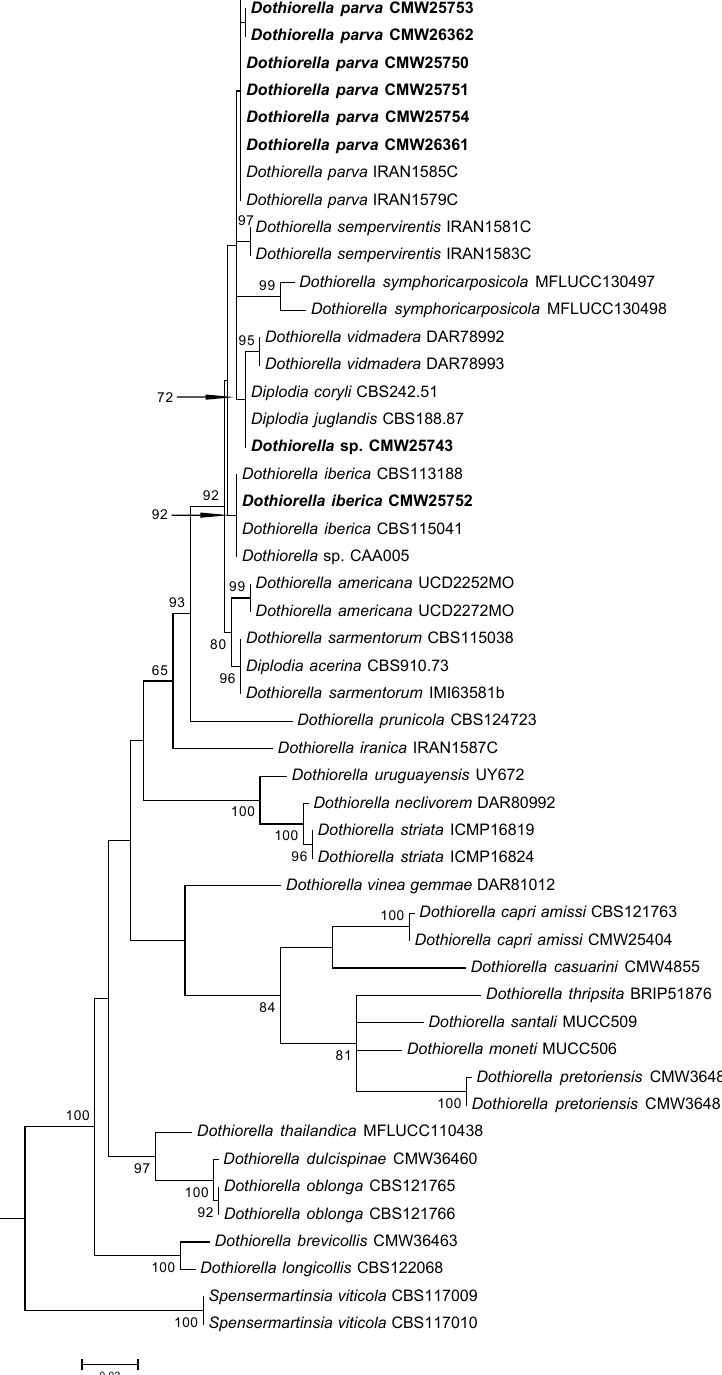
Figure 2. Maximum likelihood (ML) tree obtained from the combined ITS and EF-1α sequences of the Dothiorella species (Botryosphaeriaceae). Bootstrap support values greater than 70% are indicated next to the nodes. The tree was rooted to Spencermartinsia viticola (CBS 117010 and CBS